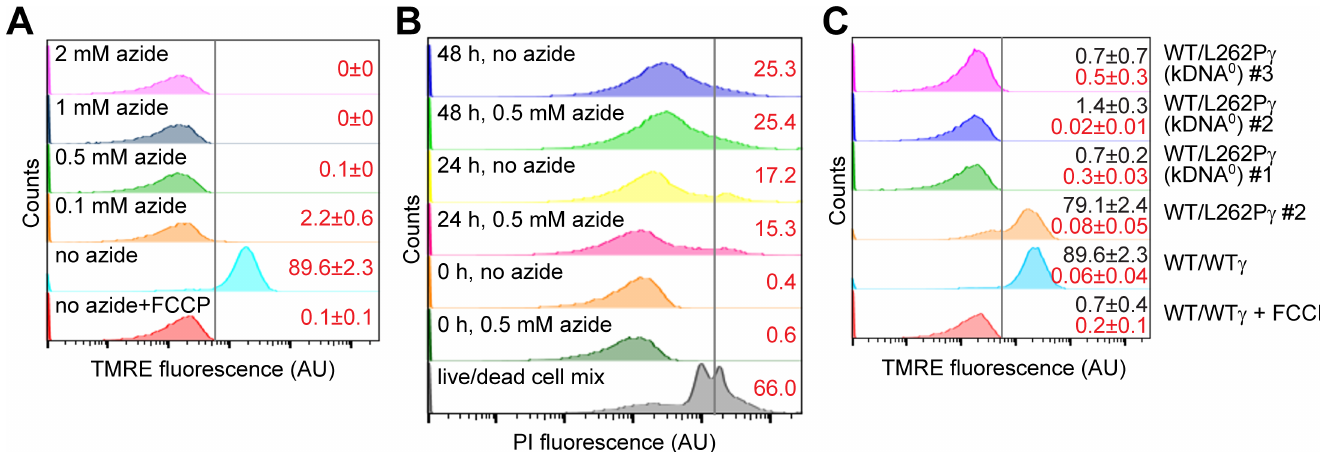
Fig 6. Stumpy forms without kDNA lack Δ C m. For all experiments, stumpy cells were purified from blood and incubated in HMI-9 medium with 10% (v/v) FCS. Specific experimental conditions were as indicated. AU, arbitrary units. (A) The effect of F 1 -ATPase inhibitor azide on the Δ C m of WT/WT γ stumpy form cells. Where indicated, cells were pre-incubated with azide for 2 h before tetramethylrhodamine ethyl ester (TMRE, 100 nM) was added to the medium. Δ C m was measured by flow cytometry (peak excitation 549 nm, peak emission 575 nm). Representative analyses are shown, n = 3. The numbers in red on the right indicate the % of cells ( ± SD) determined to be ‘ Δ C mpositive’. The ‘ Δ C mnegative’ gate (black vertical line) was set to include all counts up to the maximum fluorescence detected for WT/WT γ cells incubated with an uncoupler, carbonyl cyanide-4-(trifluoromethoxy)phenylhydrazone (FCCP, 20 mM). All counts to the right of this gate were defined as ‘ Δ C m positive’. (B) Effect of azide on viability of WT/WT γ stumpy cells. Cells were incubated in HMI-9 medium for 0, 24 or 48 h, +/- 0.5 mM azide. At each time point, 1x10 6 cells were stained with propidium iodide (PI) and TMRE, and analysed by flow cytometry. The numbers in red on the right indicate the average % dead cells within each population; n = 2. The black vertical line indicates the gate for live/dead staining by PI, established as shown in S5B Fig. The TMRE assays for these samples are shown in S5C Fig. (C) The Δ C m of stumpy form cells with genotypes as labelled, measured as described for panel A, and indicated as % ‘ Δ C m positive’ cells (average ± SD) by the black value on top. The numbers in red below give the % of dead cells within each cell population (average ± SD), measured by PI staining as described for panel B.